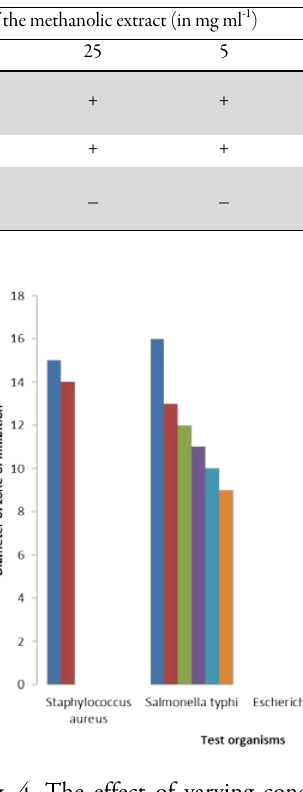
Fig. 4. The effect of varying concentration of the Ethanolic extract on the test